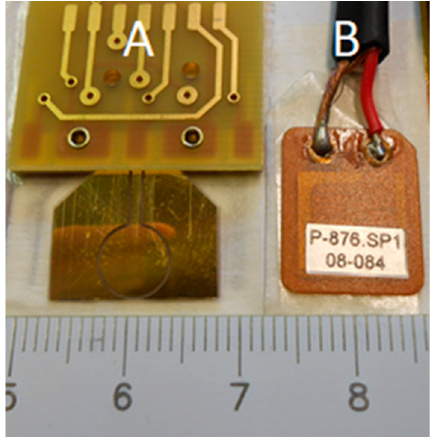
Figure 6. Example of two different type of piezoelectric sensor for SHM: ( A ) circular PVDF sensor made with bioriented PVDF film furnished by Precision Acoustics, ( B ) Piezocomposite, model DuraAct produced by Physik Instrumente. At the bottom, the ruler tick is 1 mm. Table 1. Characteristics of